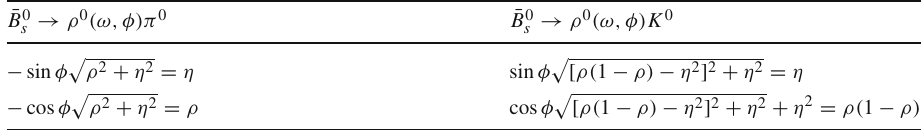
Fig. 1 The diagrams of ¯ B 0 s → π + π − π 0 ( K 0 ) decay process Table 2 The relationships about ρ and η for ¯ B 0 → ρ (ω,φ)π 0 ( K 0 ) s